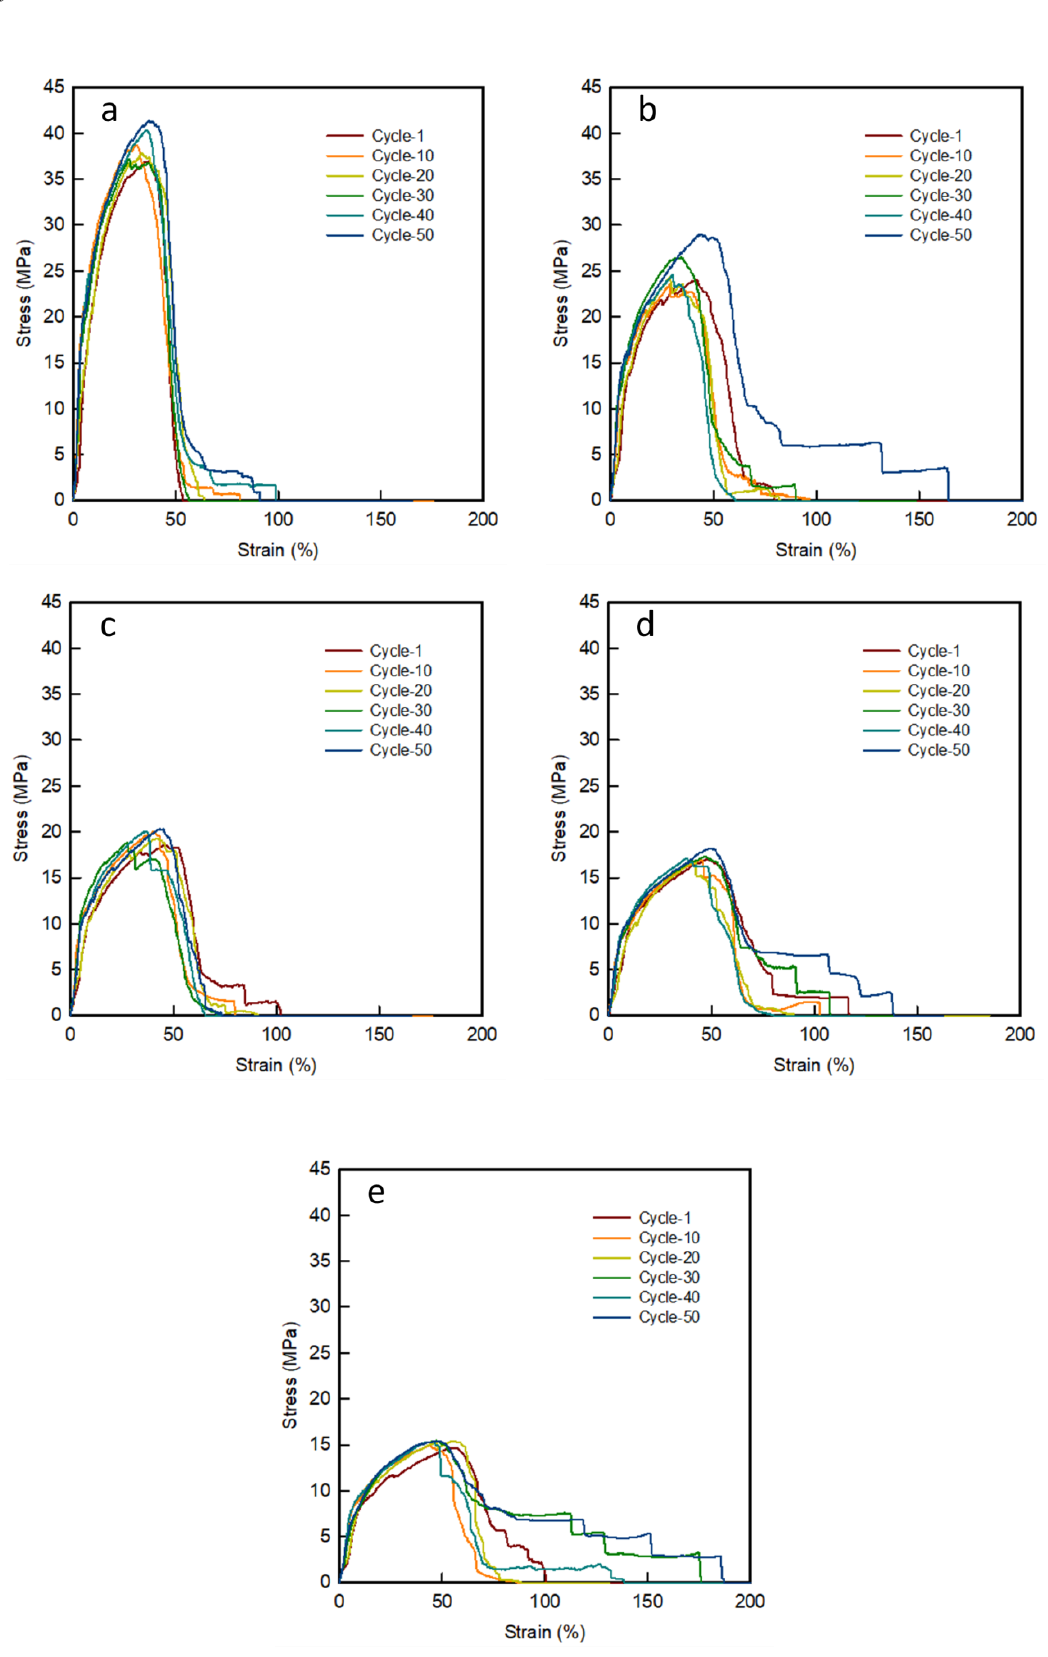
Figure 7. Stress-strain curve of 3D-printed sinusoidal sample/nylon composite with various thicknesses and various cycles ( a ) 0.2SM/NF, ( b ) 0.4SM/NF, ( c ) 0.6SM/NF, ( d ) 0.8SM/NF, and ( e )